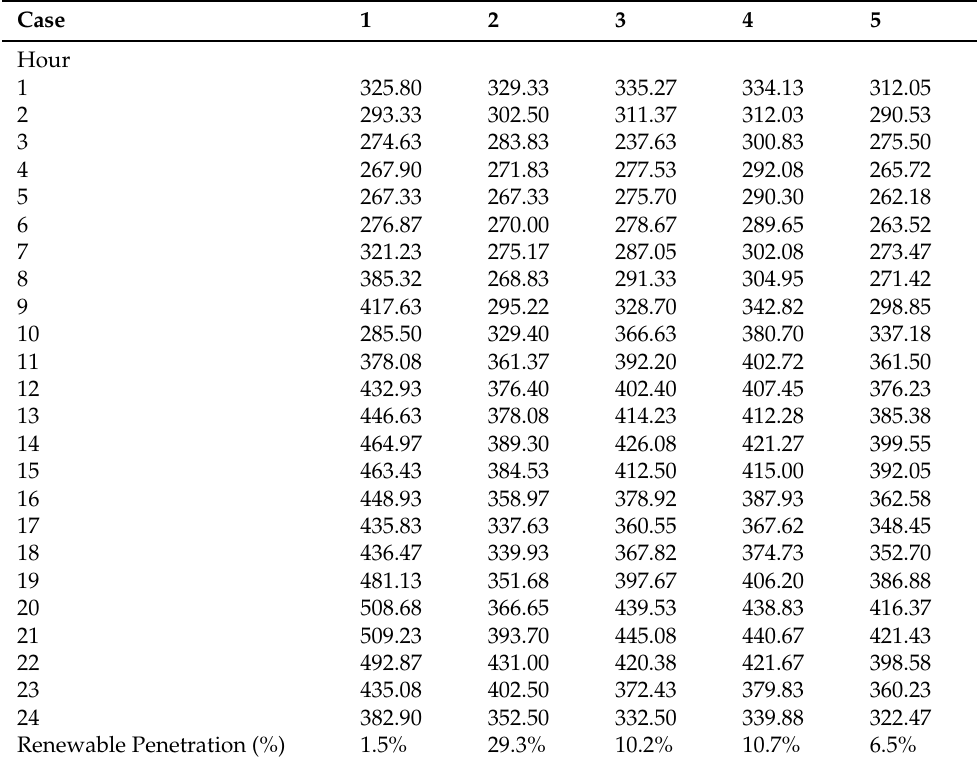
Table 3. Hourly demand (MW) and average renewable penetration (%) for five